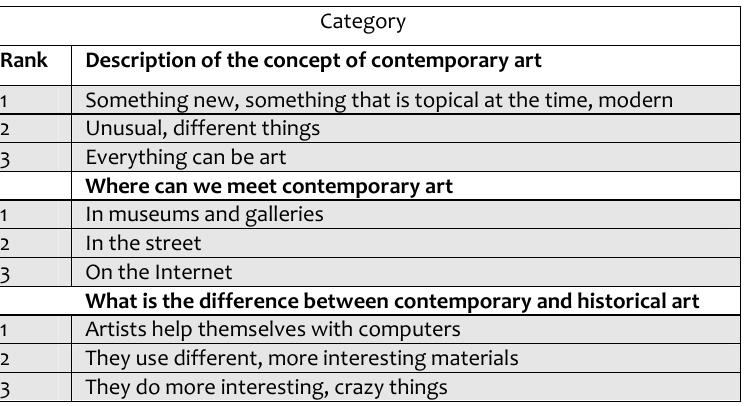
Table 3: Ranking order of categories of some answers relating to questions about contemporary